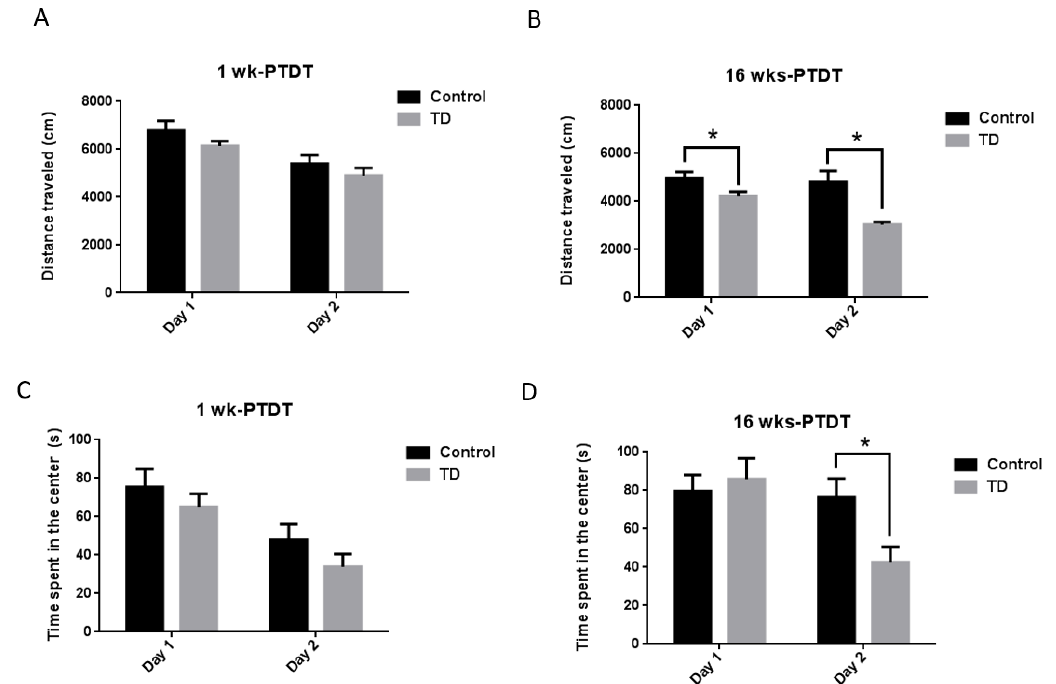
(F(1, 17) = 0.219, p = 0.646).